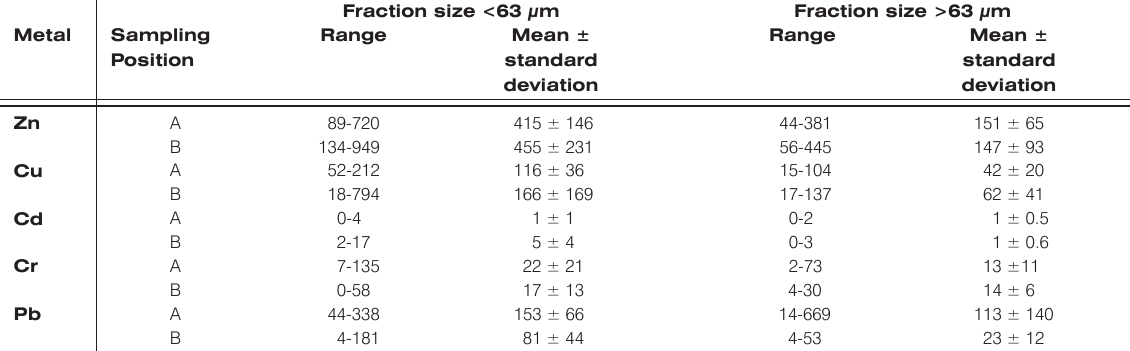
Table 3. Spearman rank correlation coefficient among metal concentrations for integrated sample *